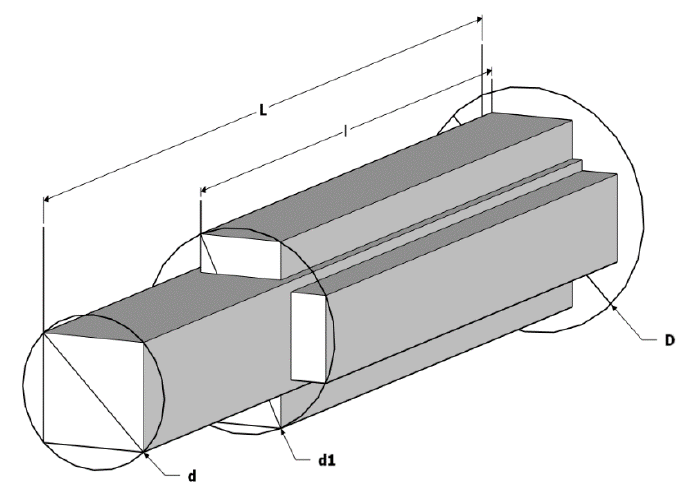
Figure 10. Principle of shorter timber calculation.